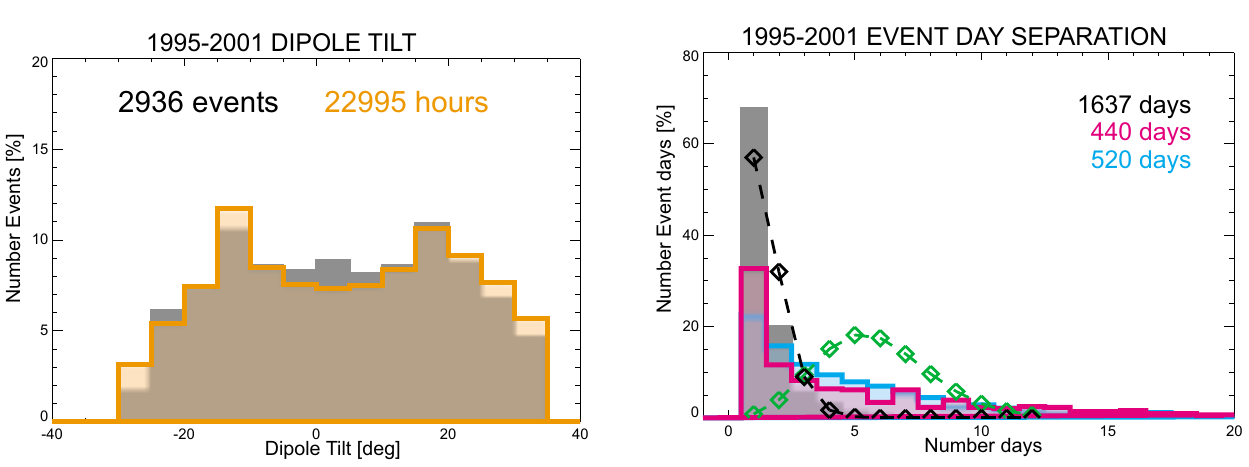
Fig. 7. Relative occurrences shown as functions of dipole tilt angle at the time of events. The format of the plot is largely the same as for Fig. 2. For reference, the background distribution of hourly dipole tilt angle values for the entire period covered in the analysis (25550h) is displayed in orange.